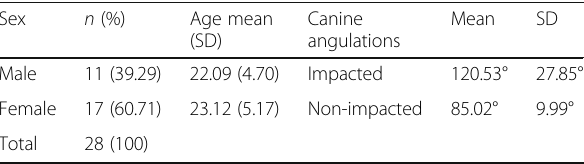
Table 2 Demographic characteristics and canine angulations according to the side of impaction